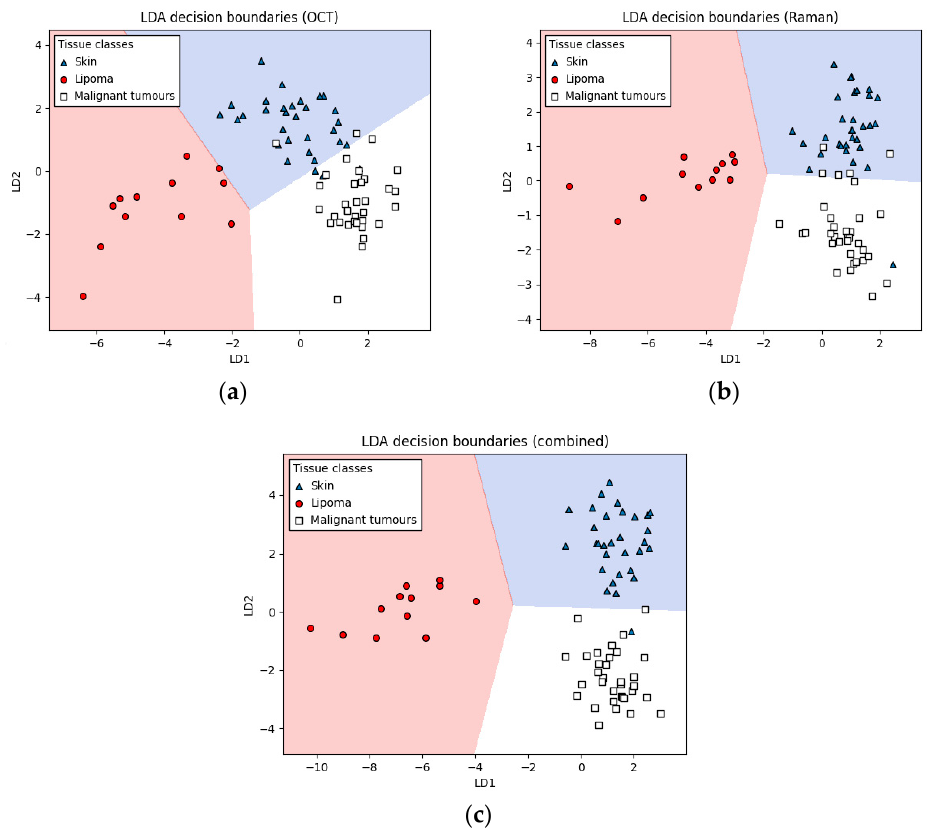
Figure 7. LDA decision boundaries for skin, lipoma, and malignant tumors. Three datasets are shown—OCT ( a ), Raman ( b ), and combined OCT + Raman ( c ). Data are plotted on the two most significant linear discriminants, LD1 and LD2.